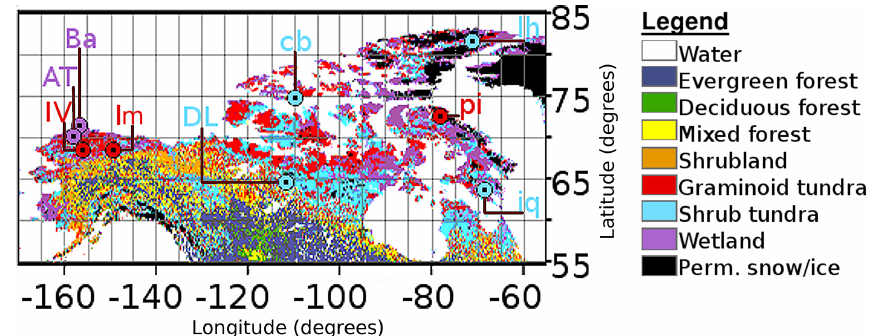
Figure 1. Map of all North American calibration and validation sites and their predominant vegetation types: graminoid tundra (red), shrub tundra (cyan) or wetland (purple). Calibration sites are indicated in all caps (e.g., AT), year-round validation sites are capitalized (e.g., Im), and growing season validation sites appear in lowercase (e.g., cb). For a summary of all study site locations, please refer to Table 3. Table 4. MBE and RMSE (in µmol CO 2 m − 2 s − 1 ) from comparisons of 3-hourly PolarVPRM NEE, to July 2008 eddy covariance observa- tions of NEE at four Canadian Arctic validation sites. Cape Bounty Iqaluit Lake